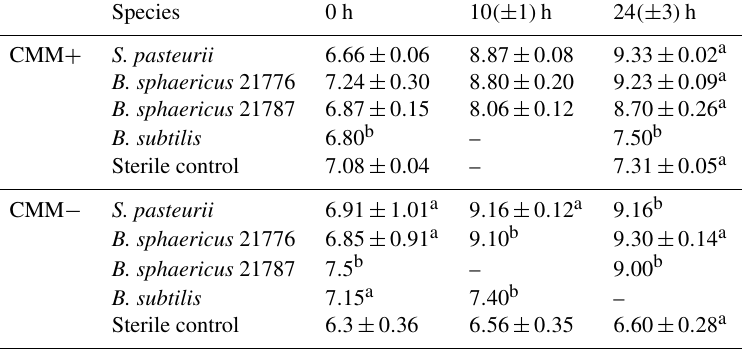
Table 1. Change in pH in aerobic calcium-inclusive (CMM + ) and calcium-exclusive experiments (CMM − ). Results are averages from triplicate experiments unless stated otherwise. Data for hour 0 were taken immediately after